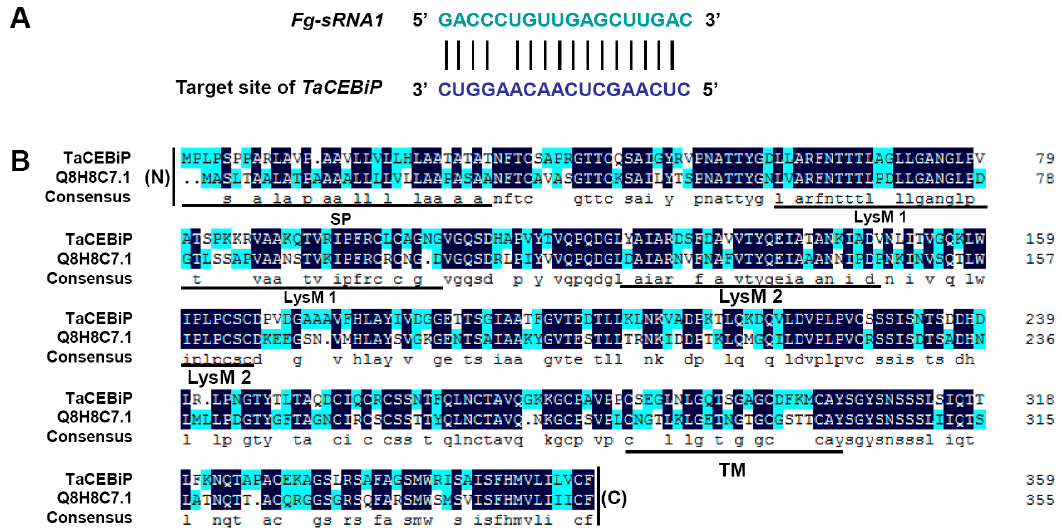
Figure 1. Sequence information of Fg-sRNA1 and TaCEBiP . ( A ) Schematic diagram of Fg-sRNA1 (green color) and its target site (blue color) in TaCEBiP of common wheat; and ( B ) alignment of the amino acid sequences between wheat TaCEBiP and Q8H8C7.1 (rice OsCEBiP ). The number on the right represents the number of amino acids. Putative coding sequence of TaCEBiP was aligned with rice Q8H8C7.1. Identical amino acids are highlighted with black boxes. SP = signal peptide; LysM 1/LysM 2, LysM motif; TM = transmembrane region; (N) = N-terminus; and (C) = C-terminus.